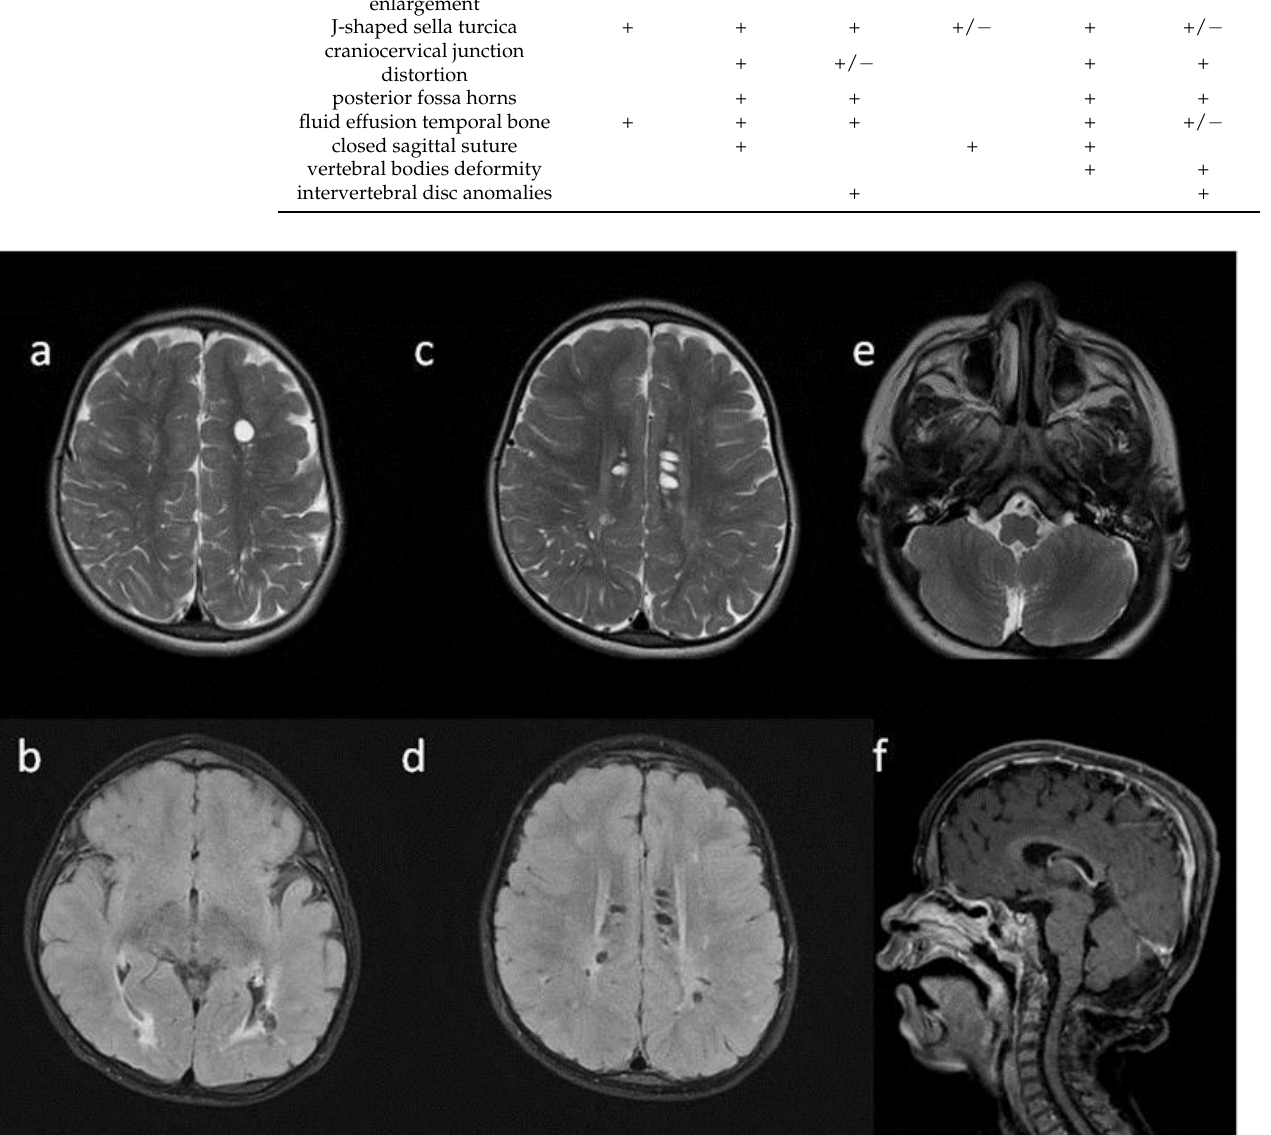
Figure 3. Brain MRI. Patient 3. ( a , e , d ) T2 axial; ( f ) T2 coronal; ( b , c ) T2 sagittal; ( b ) T1 contrast-en- hanced; ( c ) T2 FLAIR. Findings: ( a ) delayed myelination; ( b , c ) J-shaped sella turcica, dysplastic dens; ( d ) temporal bone air cells effusion, posterior fossa horns; ( e , f ) enlarged optic nerve sheath.